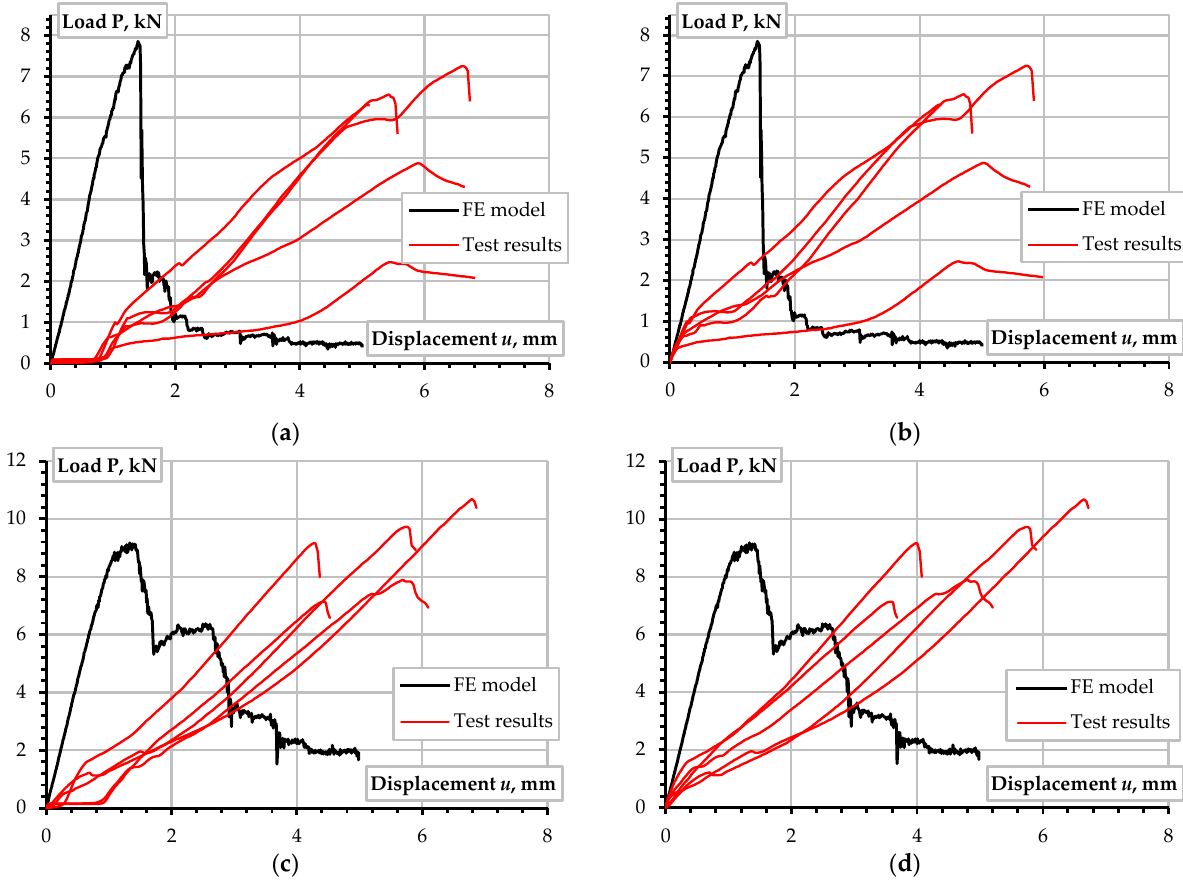
Figure 10. Load-displacement diagrams of the tested joints: ( a , b ) A-12 joint type before and after transformation of the experimental graphs; ( c , d ) The same diagrams of C-12 connections. Note: the diagrams of each graph show responses of five nominally identical test samples.